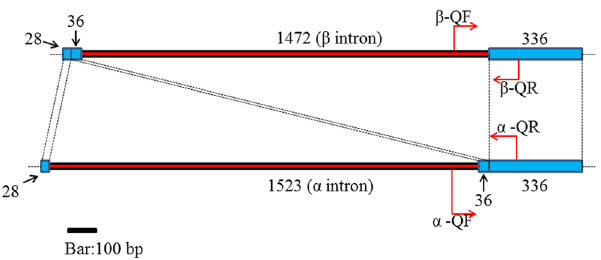
Figure 6. The schematic structure of COX1 gene with the α - and β -type introns. Blue and red regions represent the exons and introns of COX1 gene respectively. The numerical numbers show the nucleotide number of each element within this gene fragment. Elements link by imaginary lines indicate that their bases are identical. Arrows show the locations of each specific primer pair that amplified for “ α ” or “ β ” type fragments.